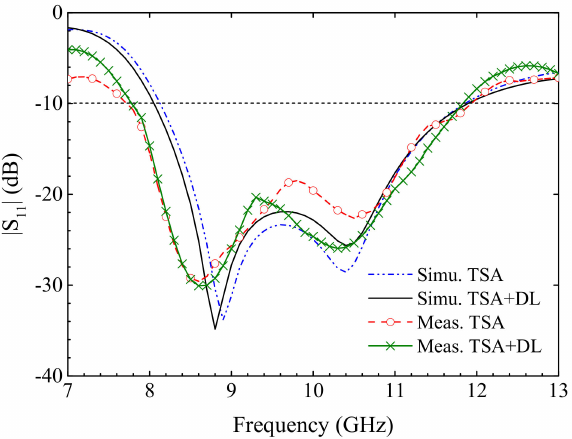
Figure 9. Measured and simulated | S 11 | of the designed antipodal tapered slot antenna (TSA), and comparison of two different antenna structures with and without dielectric lens (DL) loaded.